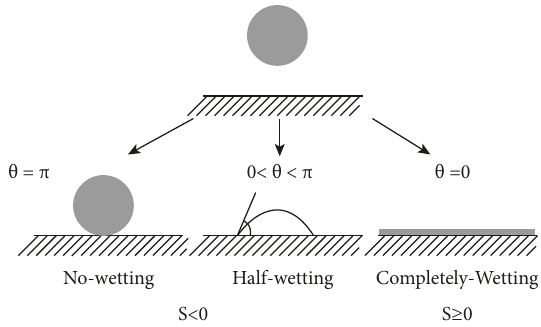
Figure 3: Spreading of liquid droplets on a solid surface.